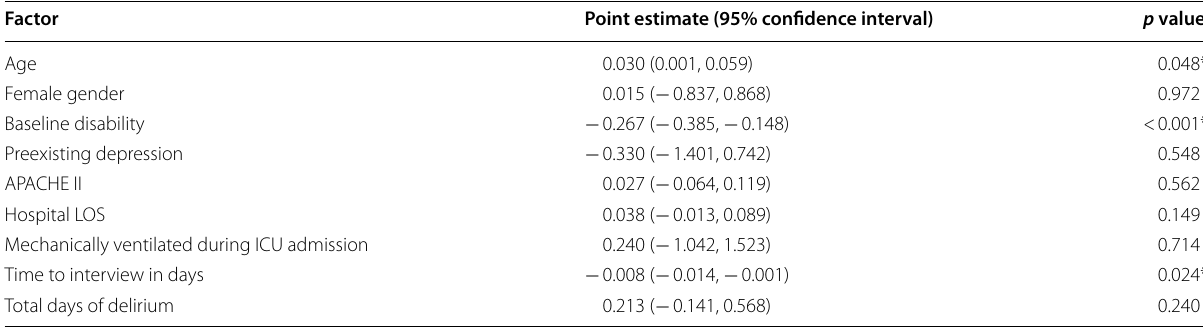
Table 3 Linear regression analysis for factors associated with change in disability scores from baseline to follow-up ( n 122) =